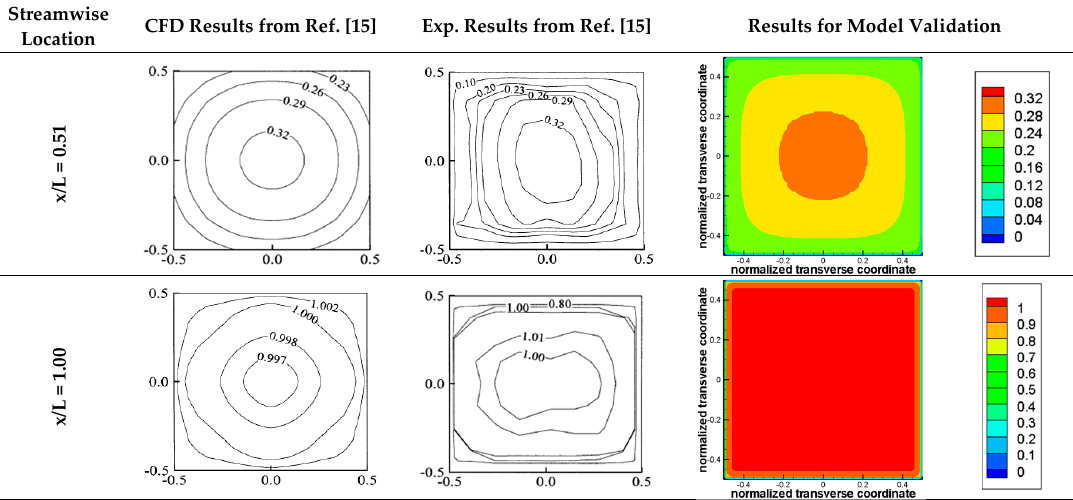
Figure 2. Comparisons with results from Fang et al. [15]. Reproduced with permission from Fang et al., J. Wind Eng. Ind. Aerodyn.; published by Elsevier, 2001.